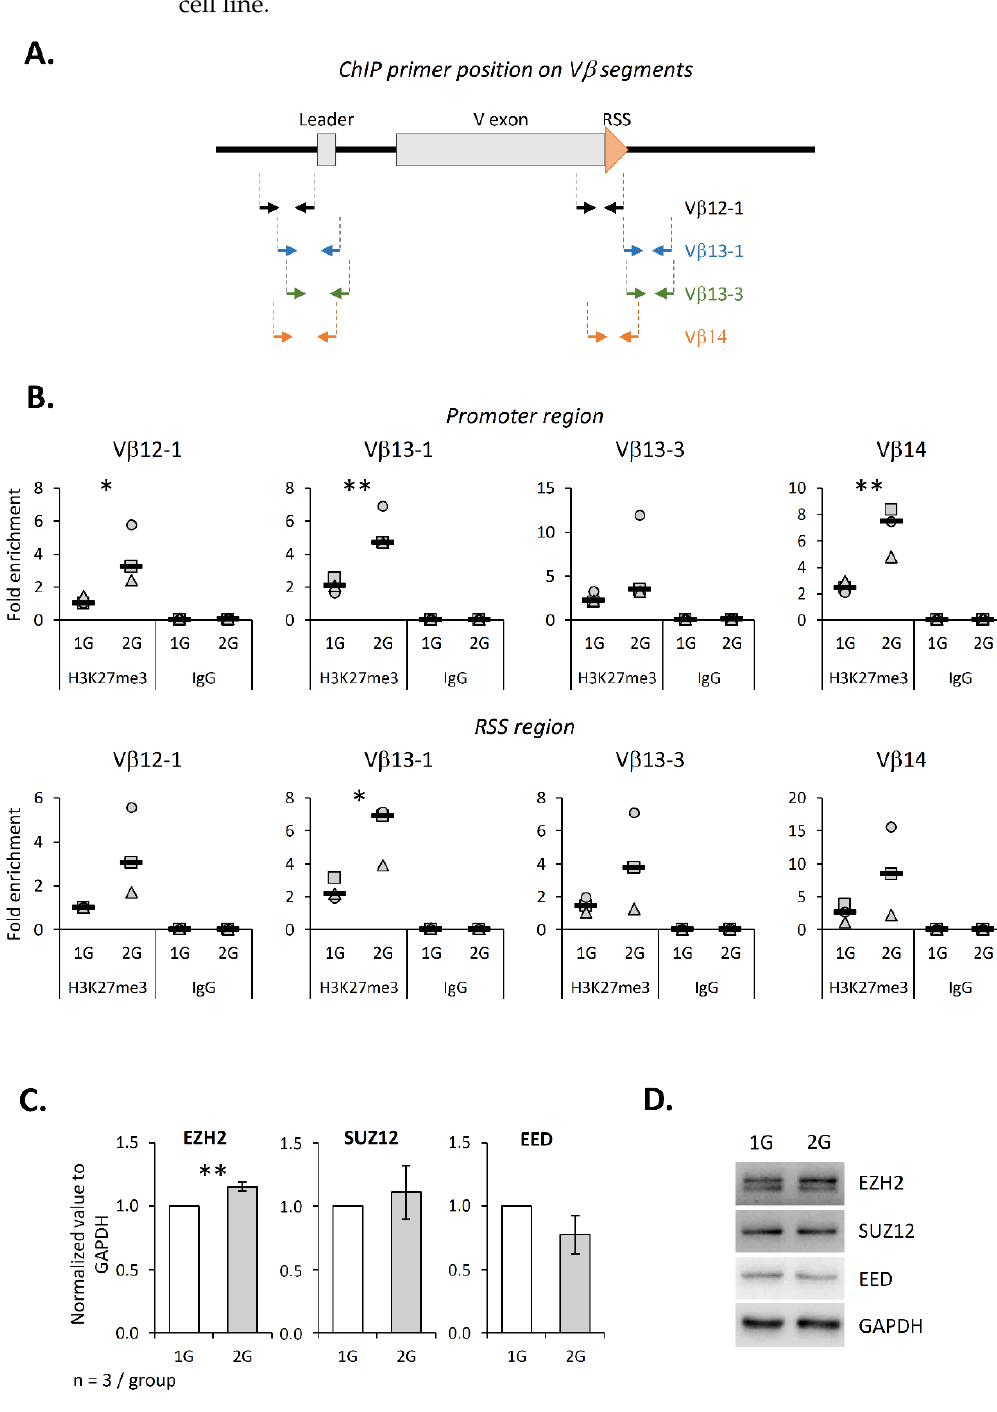
Figure 5. Hypergravity induces H3K27 tri-methylation increase at V β regions in the SCIET27 cell line. ( A ) Schematic representation of primer positions along one V β gene segment. V β 12-1, V β 13-1, V β 13-3 and V β 14 segments are composed of two exons (gray). Recombination signal sequences (RSS) are localized at the 3 ′ end of the V exon (orange triangle). Two pairs of primers were used for each V β segment; one localized on the promoter region and one localized near the RSS. ( B ) The presence of trimethylated H3K27 on the four V β segments was analyzed by ChIP. Graphics present the fold enrichment of H3K27me3 on the eight different chromatin regions. Symbols correspond to three independent experiments. Median is indicated as a black line. ( C , D ) Relative expression of PRC2 components (EZH2, Suz12 and EED) studied by Western blotting and normalized to GAPDH.